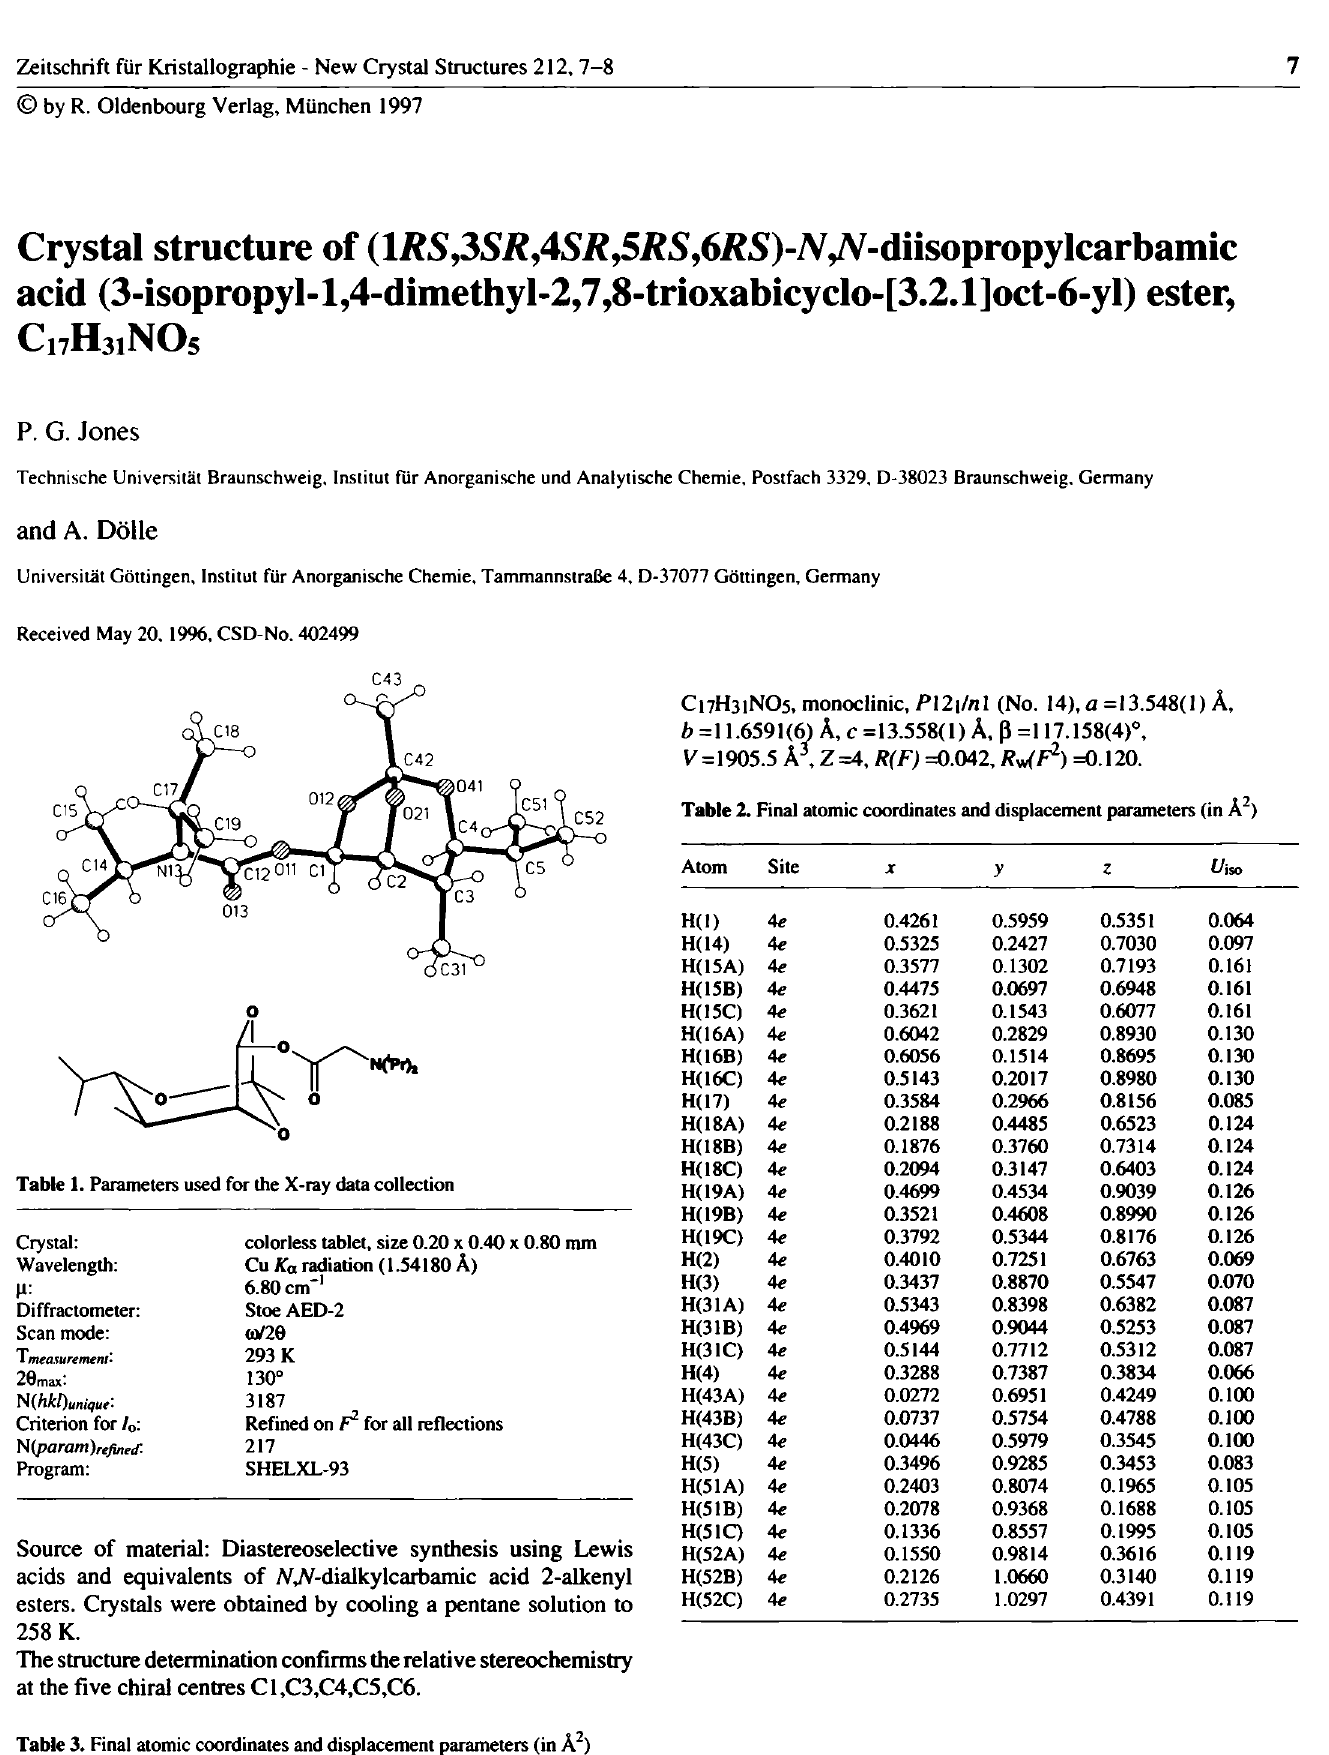
Table 3. Final atomic coordinates and displacement parameters (in À 2 )